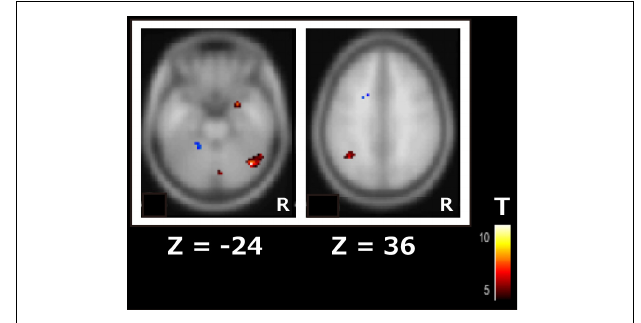
FIGURE 2 | Subtraction map of responders minus non-responders for the dorsal attention network using independent component analysis of the second scan data. The color bar indicates the t -value.